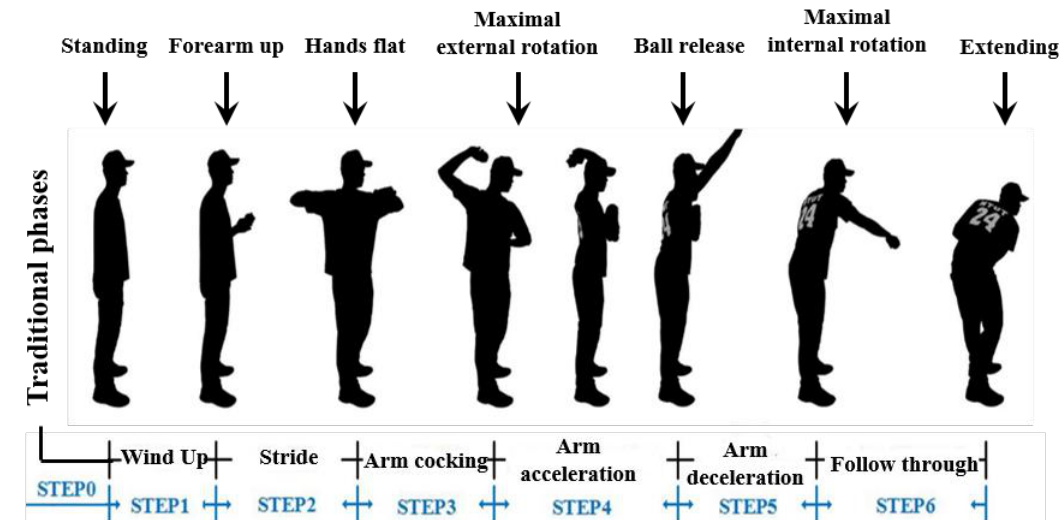
Figure 7. Upper extremity throwing action phases.